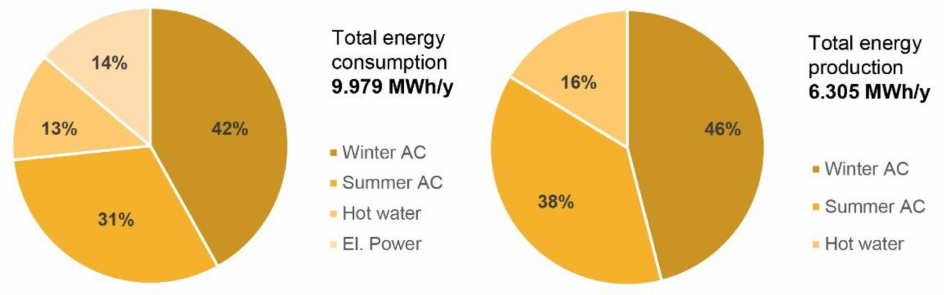
Figure 7. Total primary energy consumption and renewable energy sources (RES) energy production.